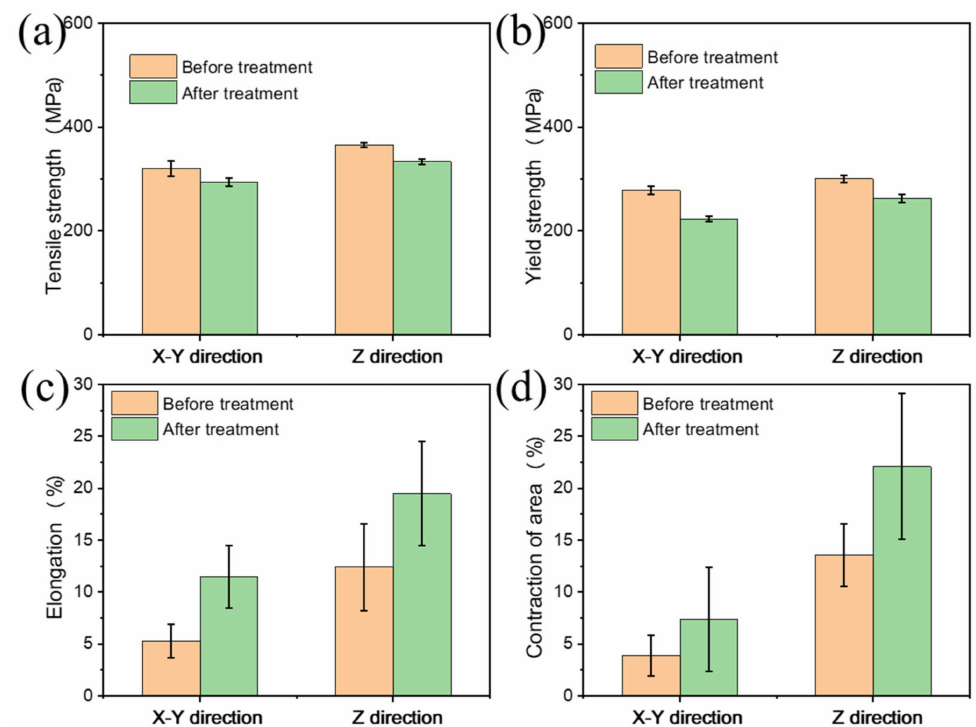
Figure 4. High − temperature tensile properties of samples before and after heat treatment: ( a ) tensile strength; ( b ) yield strength; ( c ) elongation; and ( d ) the contraction of